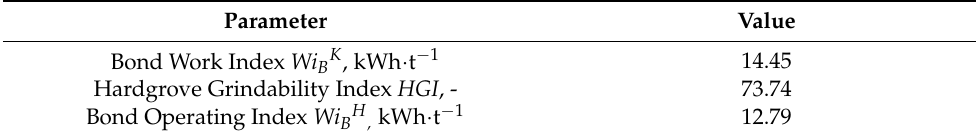
Table 2. Results of grinding parameters of limestone from the measurements.